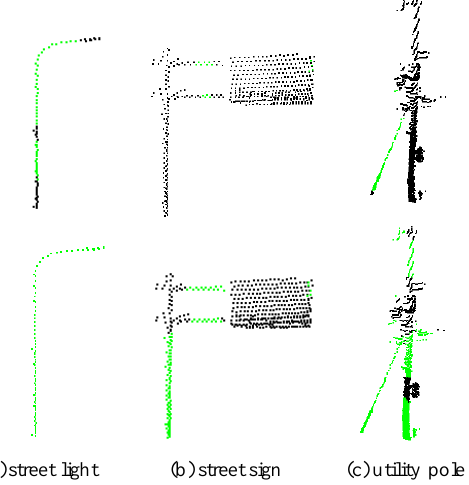
Figure 8. Effectiveness of the smoothing (green: points on the pole-like objects, black: points on the planar objects and